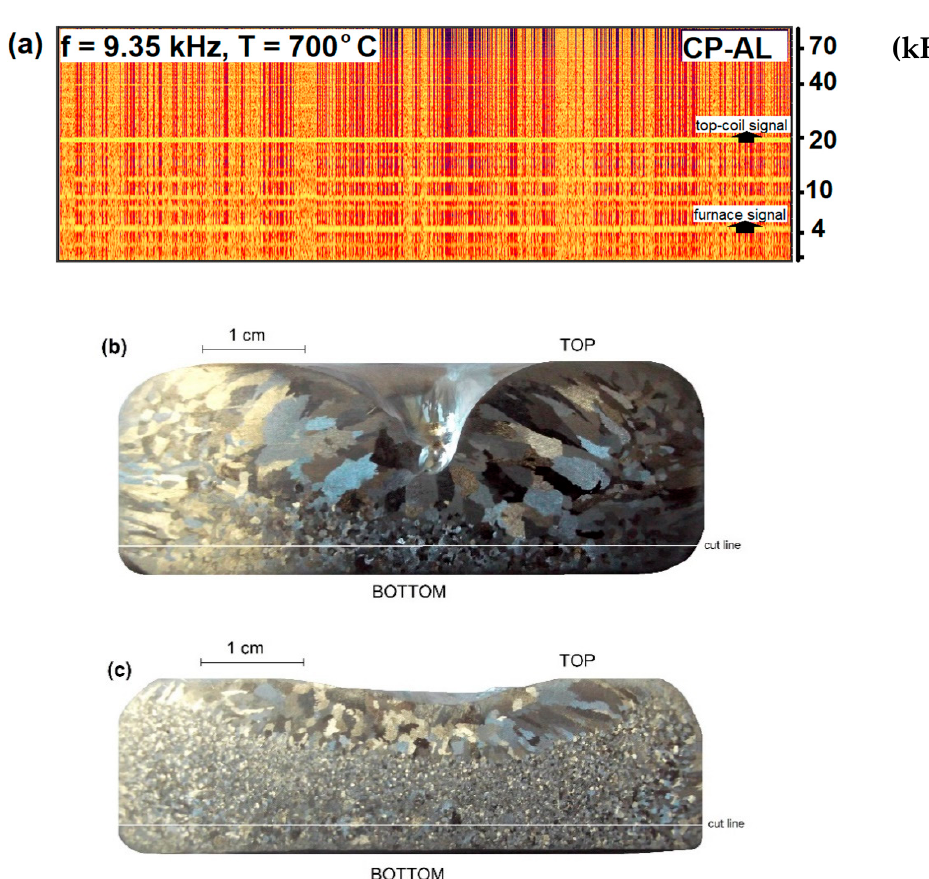
Figure 6. Grain refinement observed in CP-Al. ( a ) Recorded broadband noise during processing, ( b ) unprocessed sample, ( c ) sample processed by the contactless sonotrode at a frequency of 9.35 kHz at 700 °C. The cut line indicates the plane used for grain size measurements.